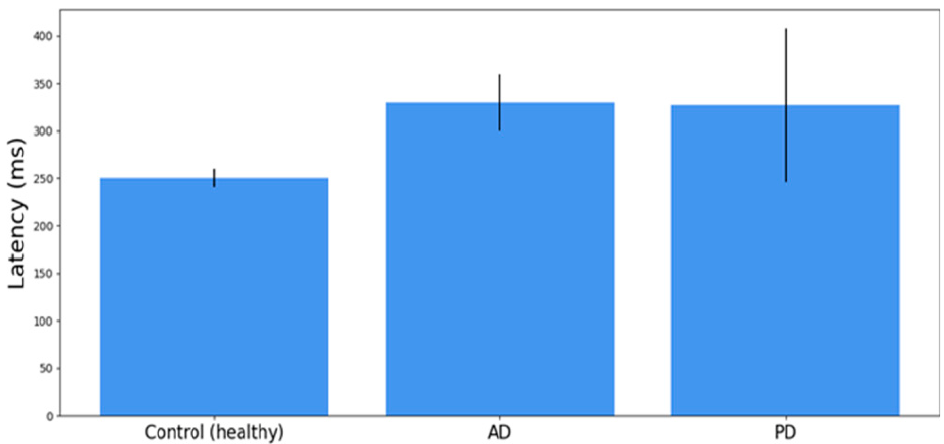
Figure 3. A comparison of the average results +/ − SD of the AS latencies, obtained in a group of 27 age-matched normal controls (healthy people), 10 AD subjects, and 12 patients with PD. The averages of the control group and AD patients are derived from the research results obtained from [43] and the average of the PD patients from the results obtained from [11].